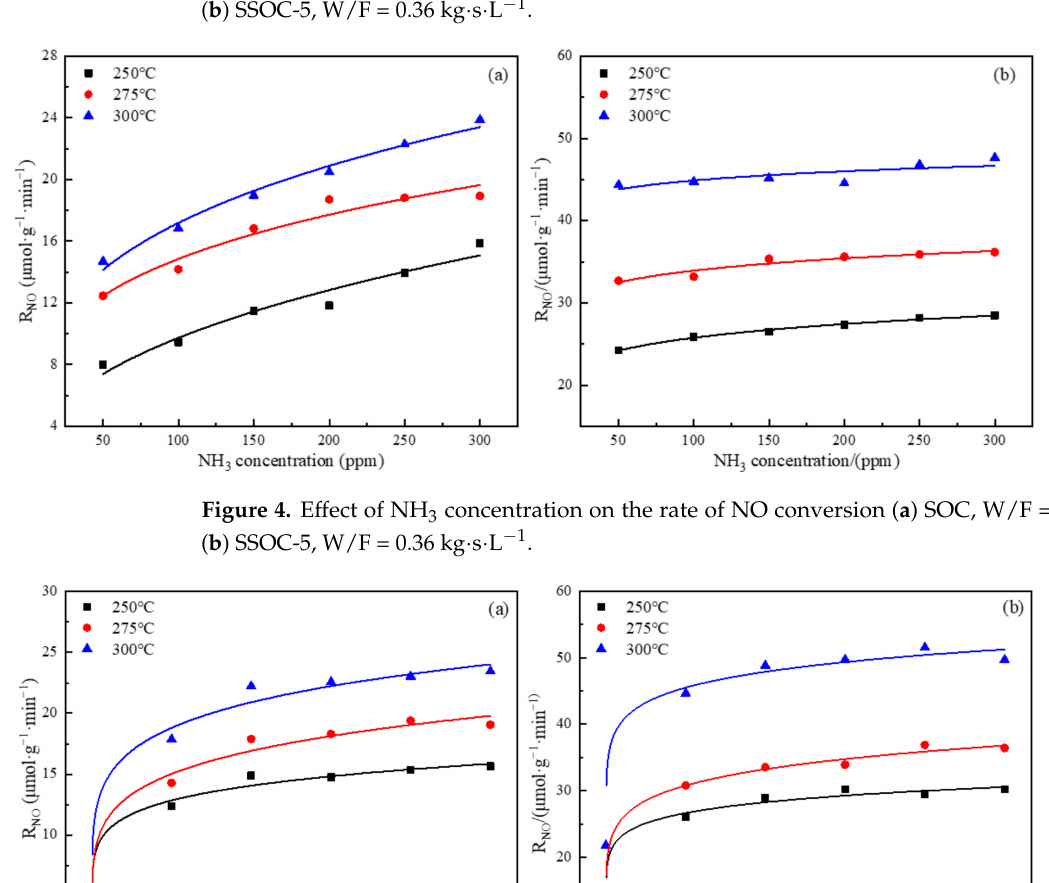
Figure 3. Effect of NO concentration on the rate of NO conversion ( a ) SOC, W/F = 0.9 kg · s · L − 1 ,